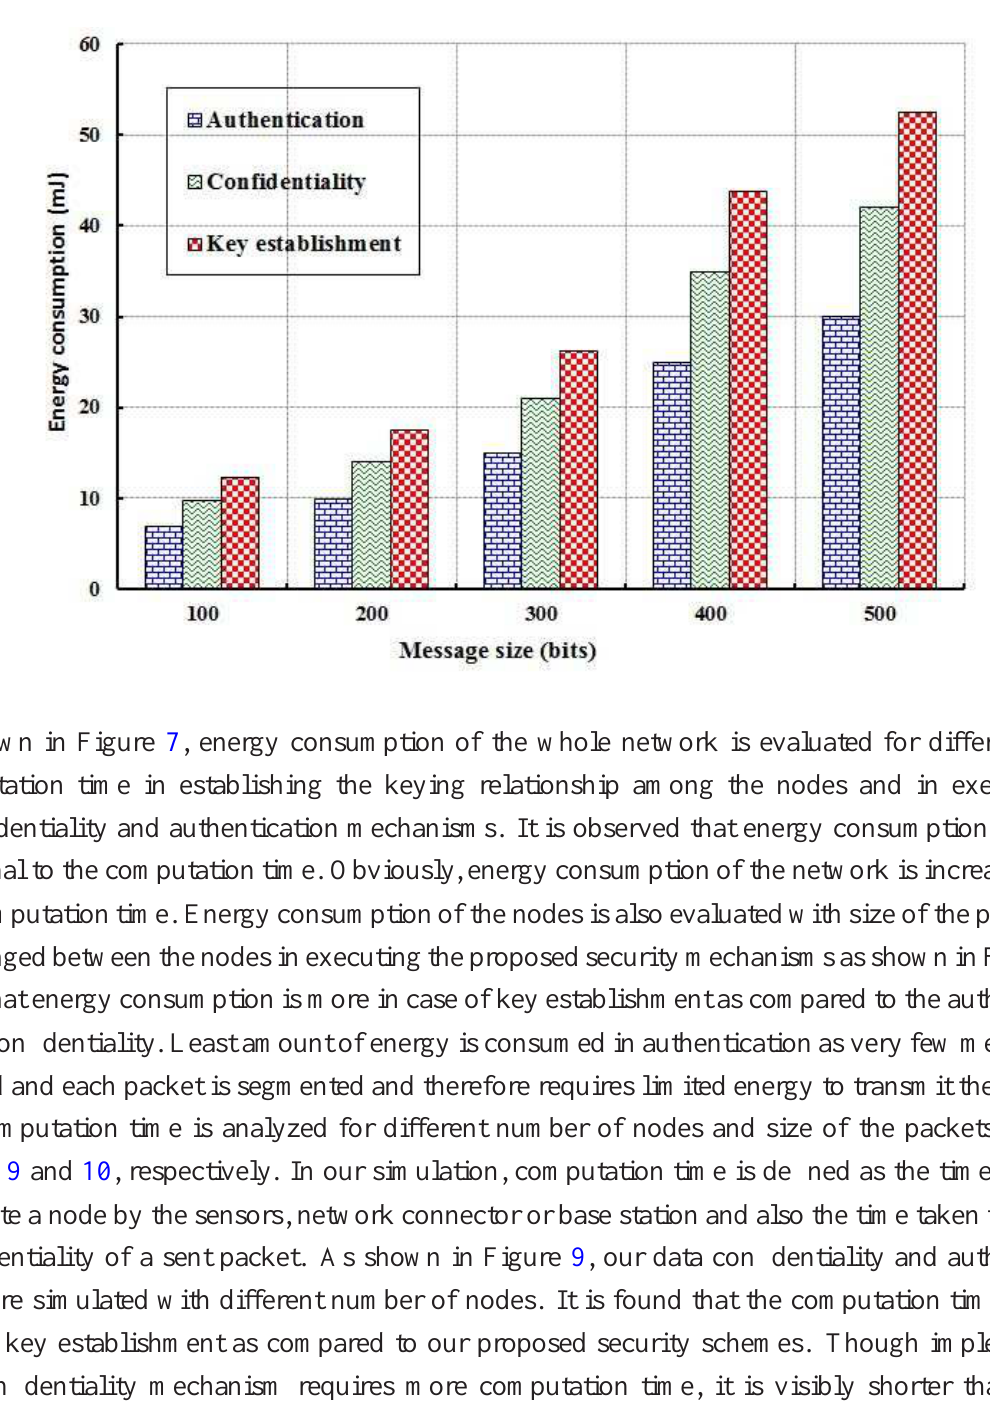
Figure 8. Evaluation of energy consumption with different message sizes in